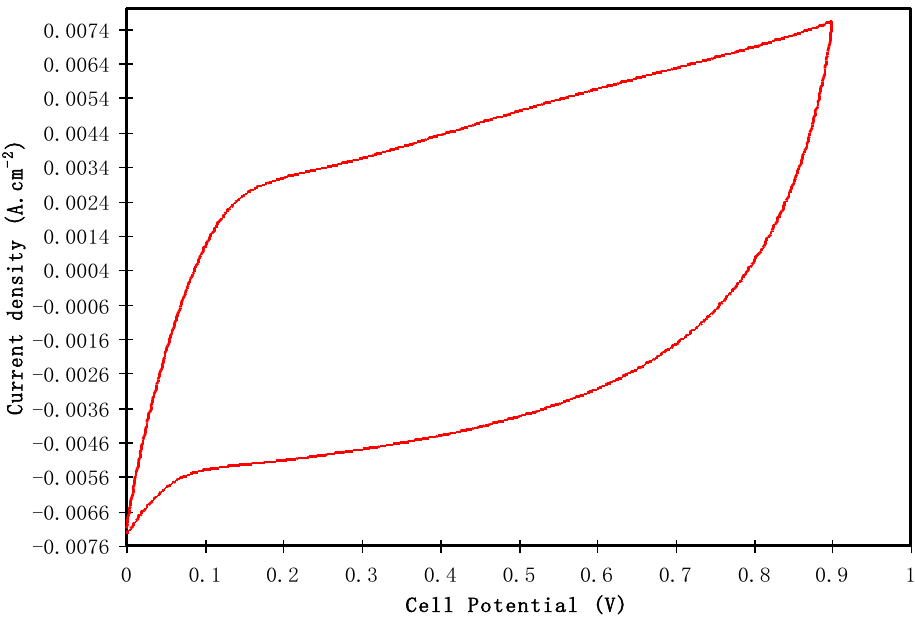
Figure 9. CV plot for the fabricated EDLC at 100 mV / s in the potential range of 0 to 0.9 V.